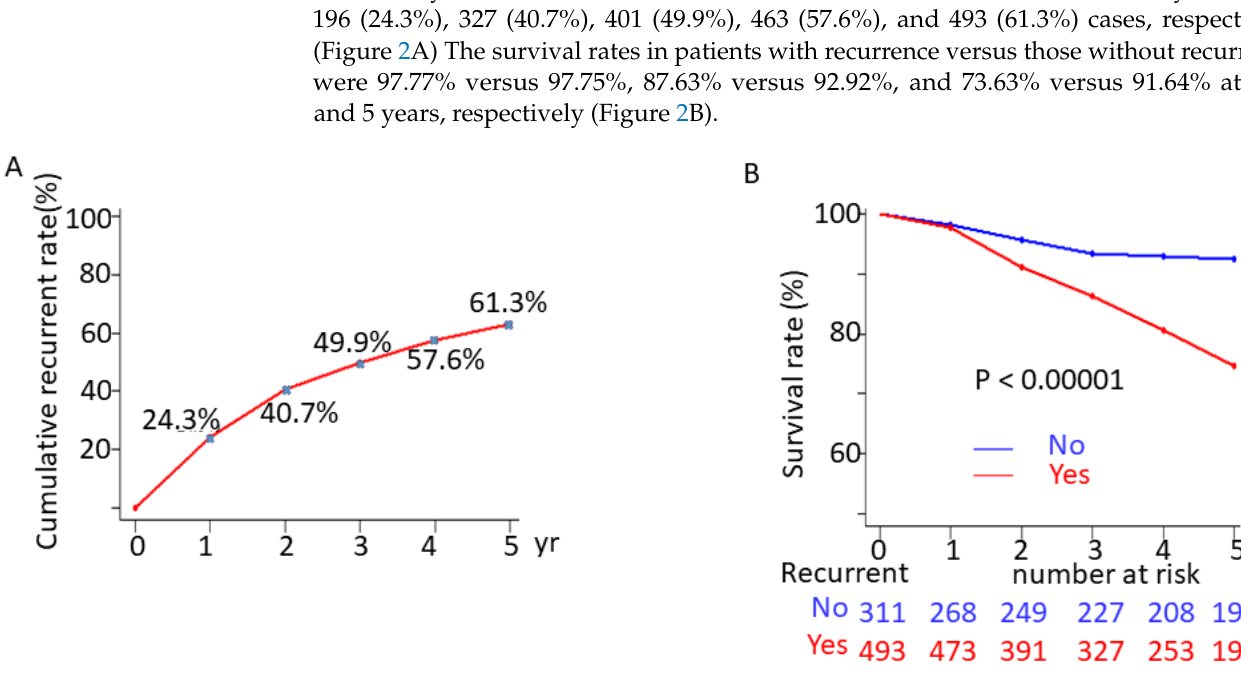
Figure 2. ( A ) Cumulative recurrent incidence of HCC post-curative treatment. ( B ) Survival rates of HCC patients after curative treatment with and without recurrence.